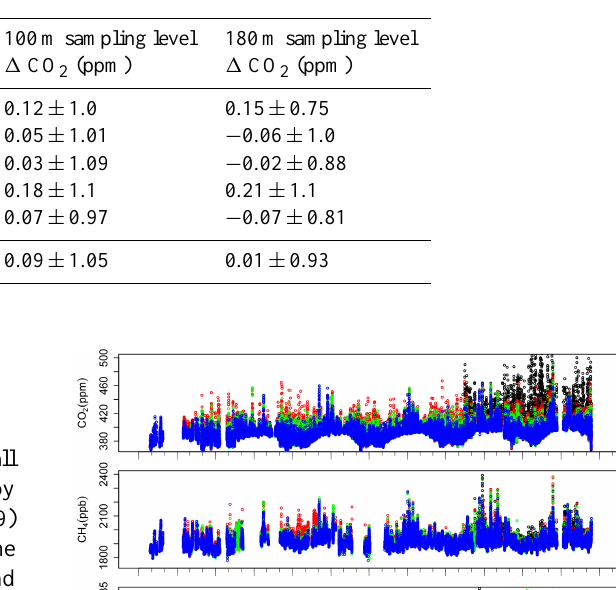
Table 4. Mean annual CO 2 difference and 1 σ standard deviation for the three ambient air sampling lines at Trainou station (GC-CARIBOU). For the mean difference of the period 2007–2012 we applied a 2 sigma filter.